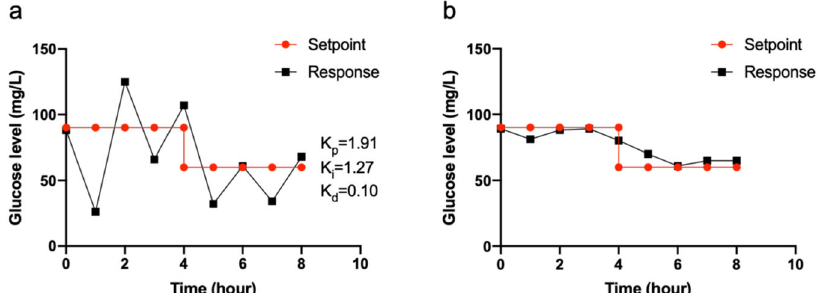
Fig. 6 Glucose level in the bioreactor. a PID controller. b GMPC